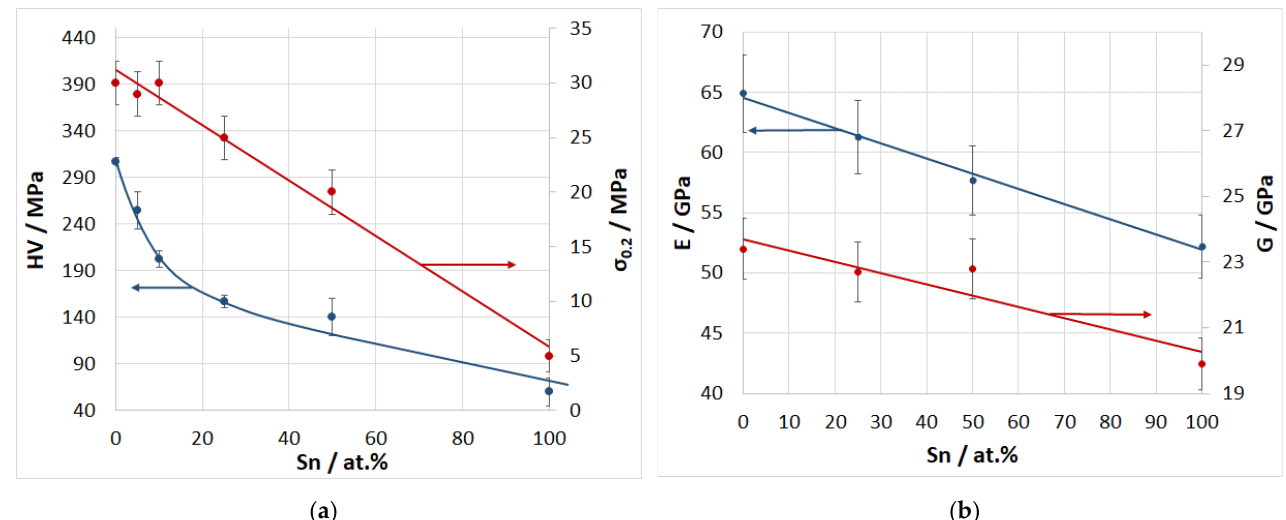
Figure 3. Dependence of microhardness, conditional yield stress ( a ) and Young’s modulus and shear modulus ( b ) of the matrix Al-Sn alloy on the tin content.